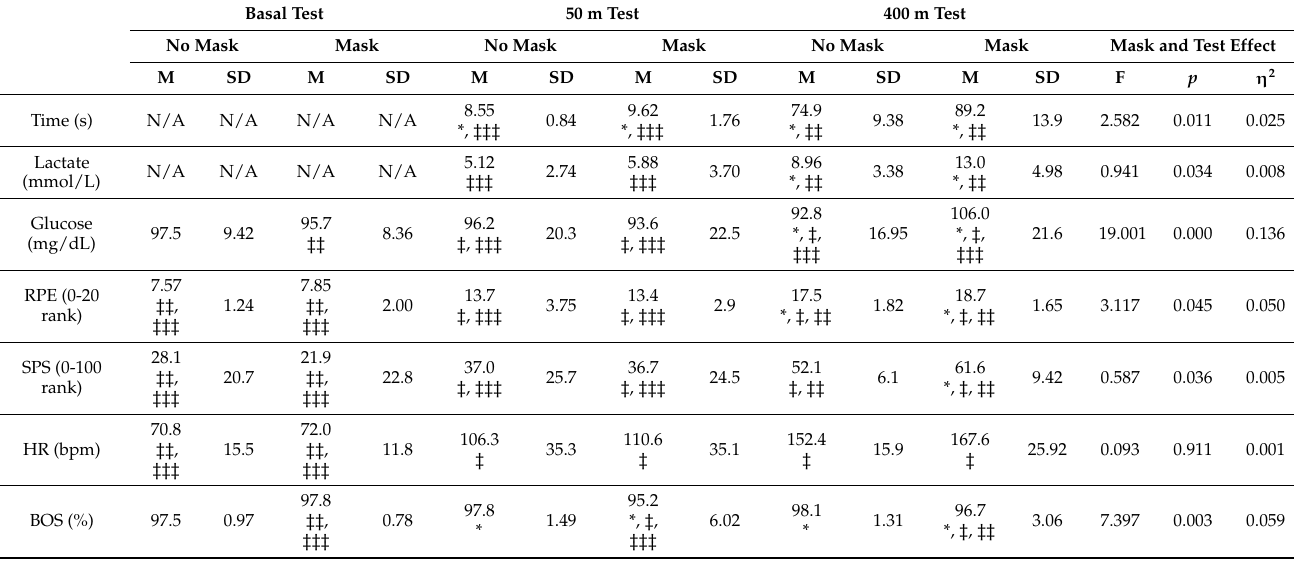
Table 1. Psychophysiological modifications in the 50 m and 400 m tests with and without mask.